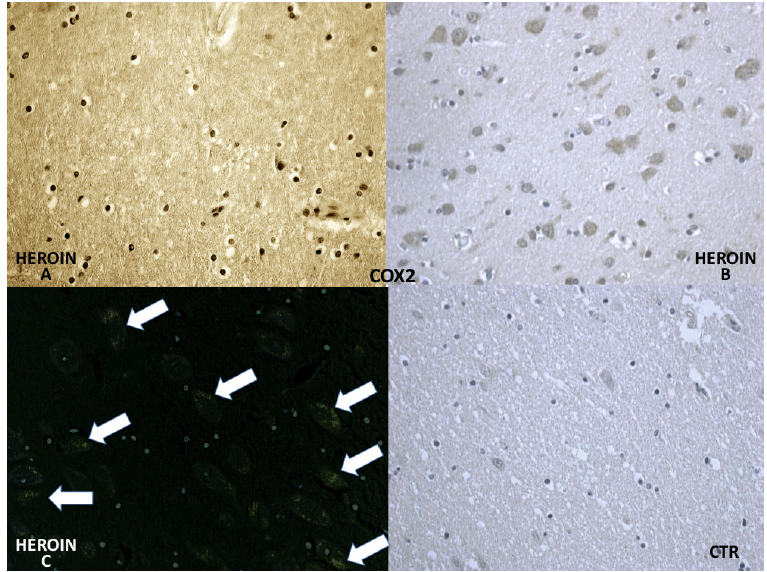
Figure 5. COX-2 appeared positive in glial cells ( A ) and was strongly expressed in neurons ( B , C ) in heroin-related death cases (confocal laser microscopy with neuronal reaction in green color). COX-2 was weakly expressed by vascular endothelium in control cases (CTR).